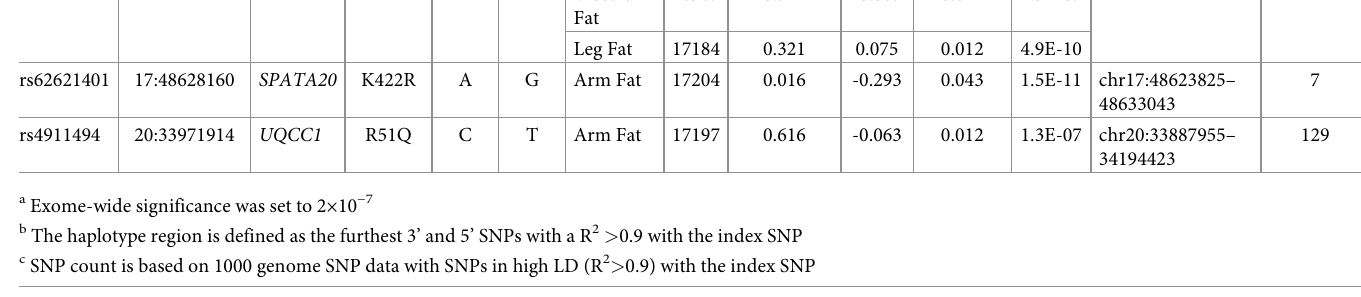
protein interacting with the centriole-ciliary interface[11] and may also be involved in DNA repair[14]. The lead variant tags a large haplotype of at least 99 SNPs (r 2 > 0.9) across a number of genes including the putative transcription factor Zinc Finger Protein 664 ( ZNF664 ) and tiple eQTL signals across this haplotype which includes three genes, i.e. CCDC92 , DNAH10